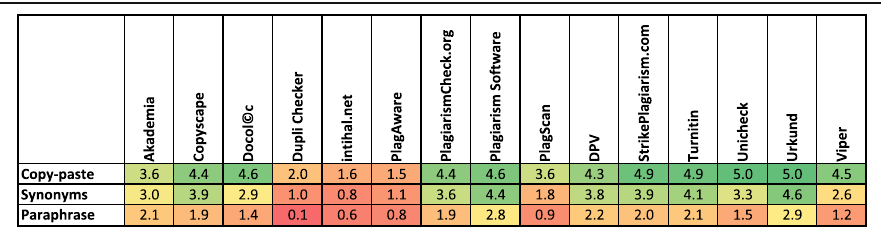
Table 5 Coverage results for Wikipedia sources